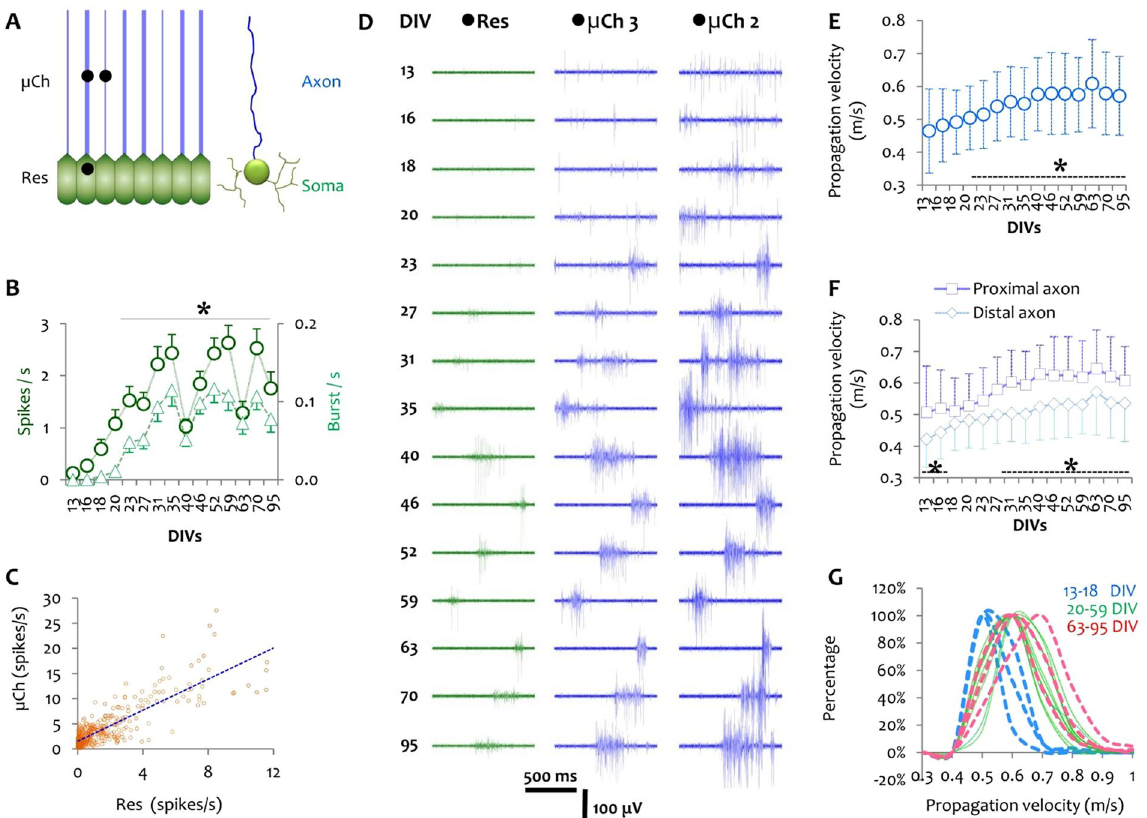
Figure 4. Long-term activity profile in different network modules and axonal propagation velocity over months. ( A ) Activity was recorded extracellularly by electrodes (dark disk) located in a reservoir module (green) or in narrow or wide microchannels (blue). ( B ) Average spike frequency (spikes/s) and burst frequency (bursts/s) in the reservoir modules (somata, green) between 13 DIV and 95 DIV. Data was pooled from reservoir modules (n = 56; including 98 electrodes) of 7 cultures. The activity in each module at each recording DIV was averaged across all MEAs and was presented as mean ± S.E.M. ( C ) Correlation of the activity (spikes/s) between each reservoir module and its corresponding microchannel for 56 reservoir-microchannel modules at 15 different time points (n = 840 data points). ( D ) Exemplary activity profile recorded from one reservoir electrode (green) and two (wide and narrow) microchannel electrodes (blue) over 95 DIV with their positions pointed out in A. ( E ) Long-term action potential propagation velocity along axons (n = 42 microchannels) of 7 cultures. Mean propagation velocity for each microchannel calculated at each DIV by averaging the velocity of all propagating spikes in that microchannel. The total number of propagating spikes is plotted in Suppl. Fig. 6A. * p < 0.05 vs . velocities at 13 DIV and 18 DIV. Velocity data is represented as mean ± StDev. (F) Average propagation velocity in proximal vs . distal segments of the same axonal bundles (n = 42 microchannels). The first 500 μ m of each microchannel were considered as the proximal section and the next 500 μ m were considered as the distal segment. * p < 0.05 vs . distal segment at each DIV. (G) Distribution of the velocity domains at each recording DIV. All velocities were categorized in 11 domains from 0.1 to 1.2 m/s (in 0.1 m/s intervals). The number of spikes belonging to each domain was counted in all microchannels at each DIV. The percentage of spikes within a specific velocity domain at each recording DIV was calculated (Suppl. Table 4). The three first and last recording DIVs are shown with blue and red dash lines,